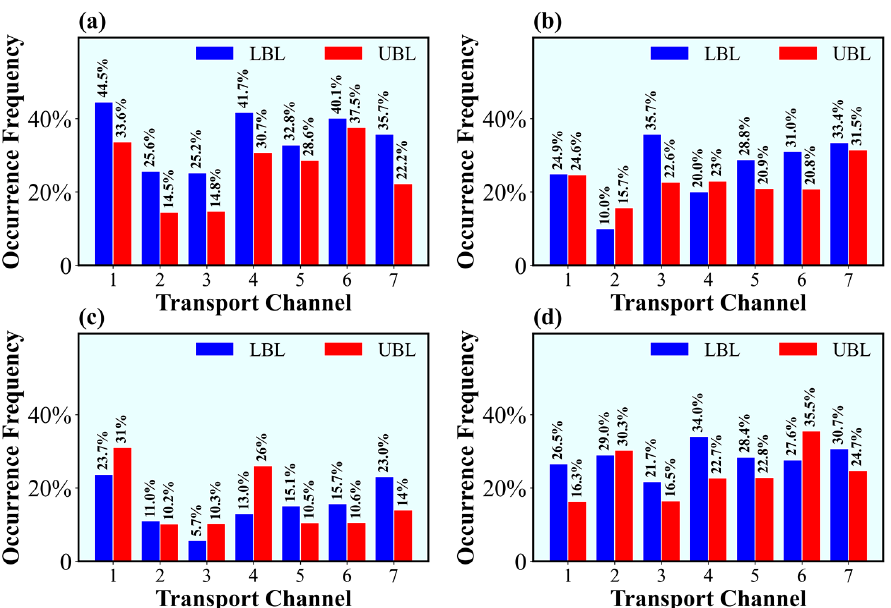
Figure 5. Occurrence frequencies of universal channels in ( a ) winter, ( b ) summer, ( c ) autumn, and ( d )